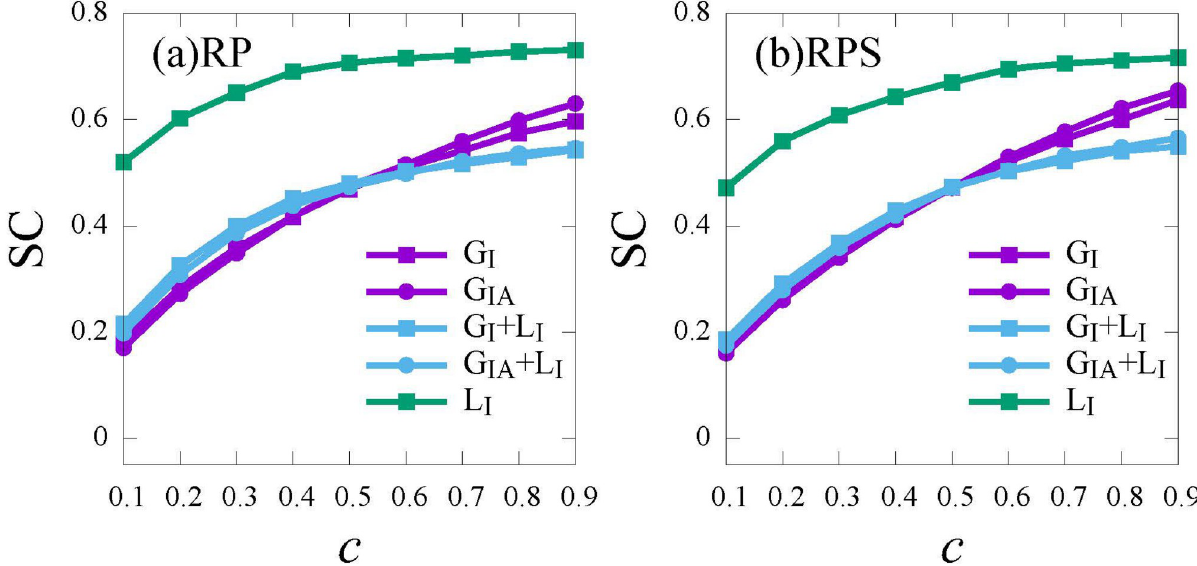
Fig 7. The social cost ( SC ) versus the relative cost c under different information sources for the RP strategy (a) and the RPS strategy (b). Global ( G I , purple, square), Global IA ( G IA , purple, circle), Global I + Local I ( G I + L I , blue, square), Global IA + Local I ( G IA + L I , blue, circle), Local I ( L I , green, square). Here, the infection rate λ =